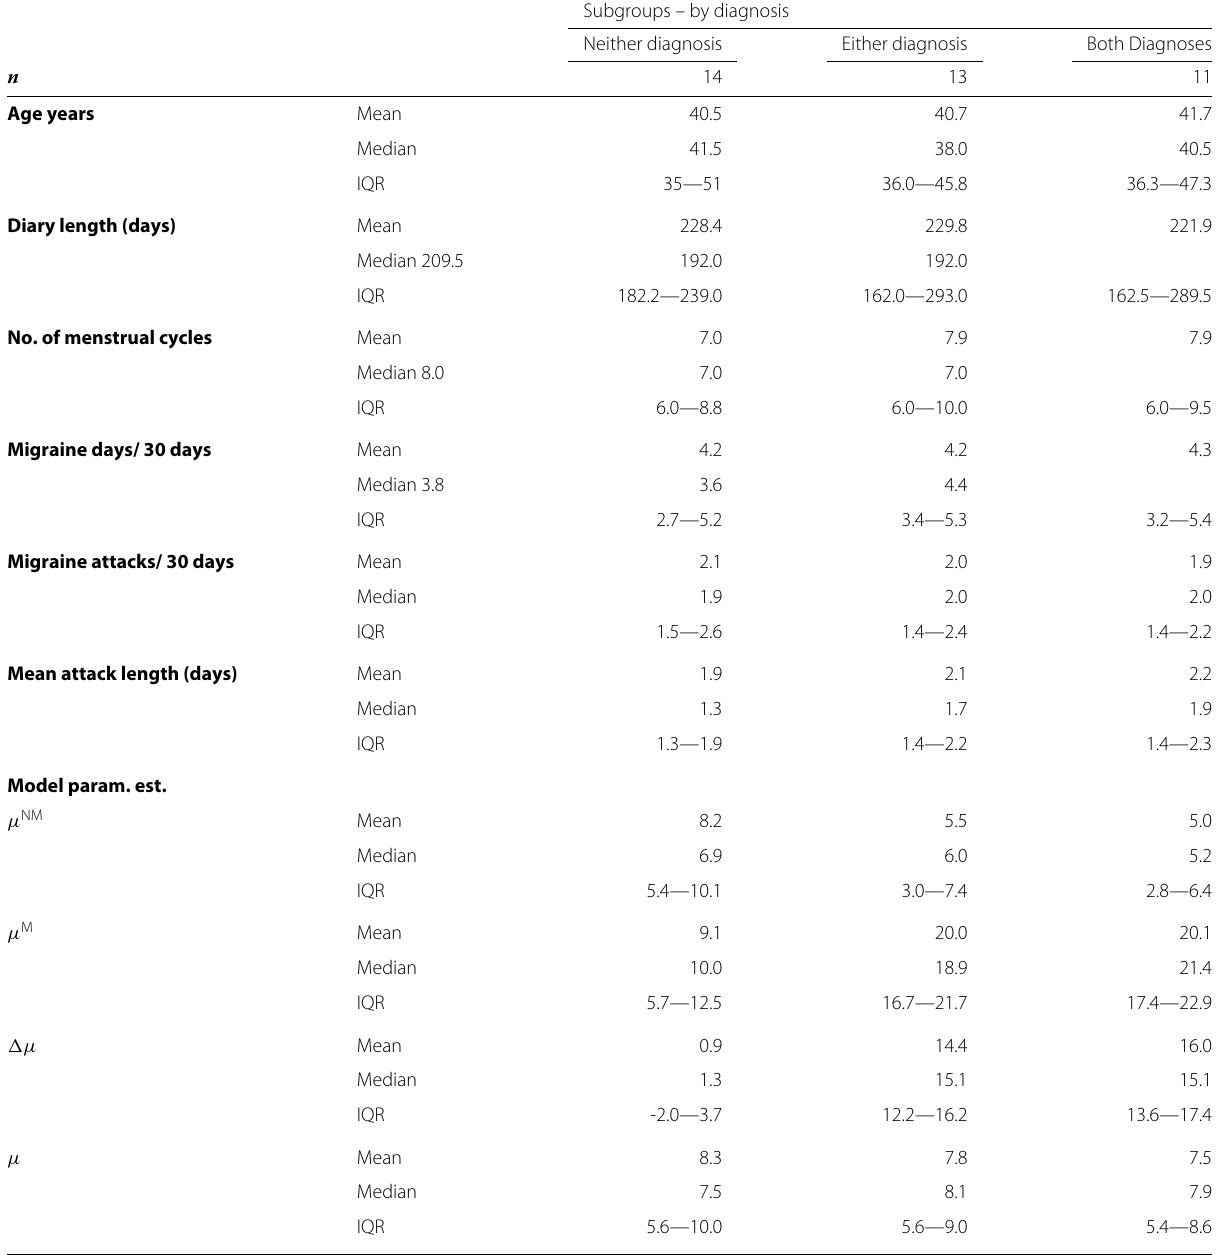
Table 3 Descriptive statistics for diagnosis-derived subgroups